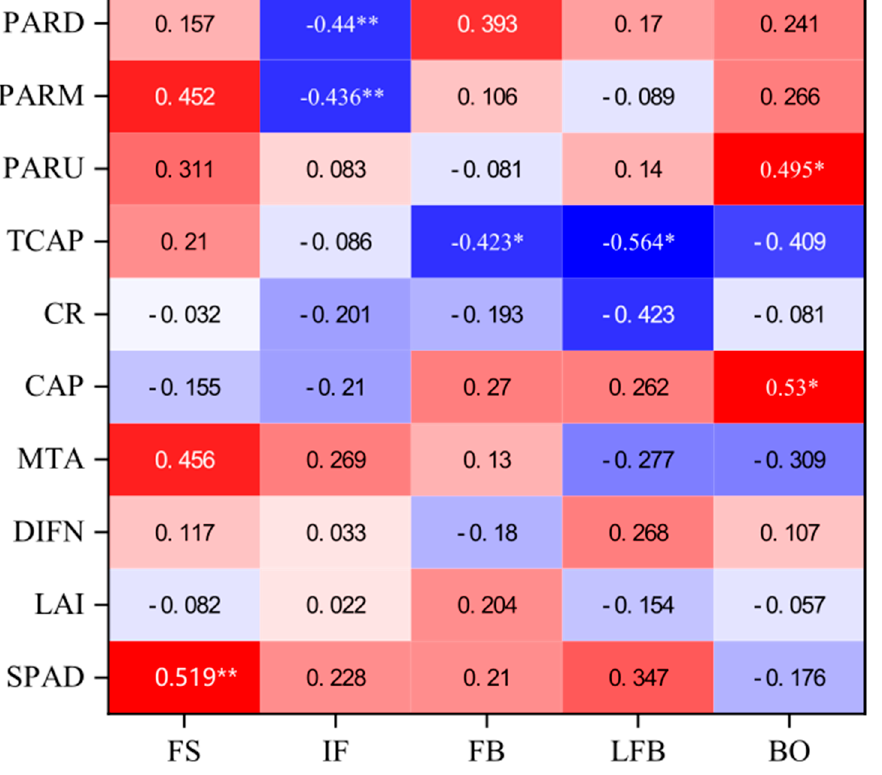
Figure 9. Correlation analysis between yield and various cotton indicators in different periods. Note: * and ** indicate significance at 0.05 and 0.01, respectively. FS, full-squaring stage; IF, initial flowering stage; FF, full-flowering stage; FB, full-boll stage; LFB, late full-boll stage; BO, boll-opening stage.